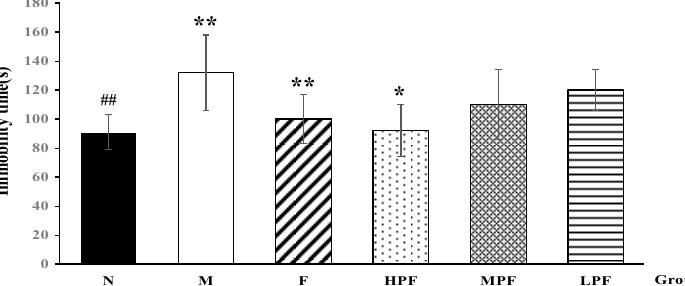
Figure 3. E ff ects of PF on the immobility time in FST (compared with the normal control group, ## p < 0.01; compared with the LPS-induced model group, * p < 0.05, ** p <